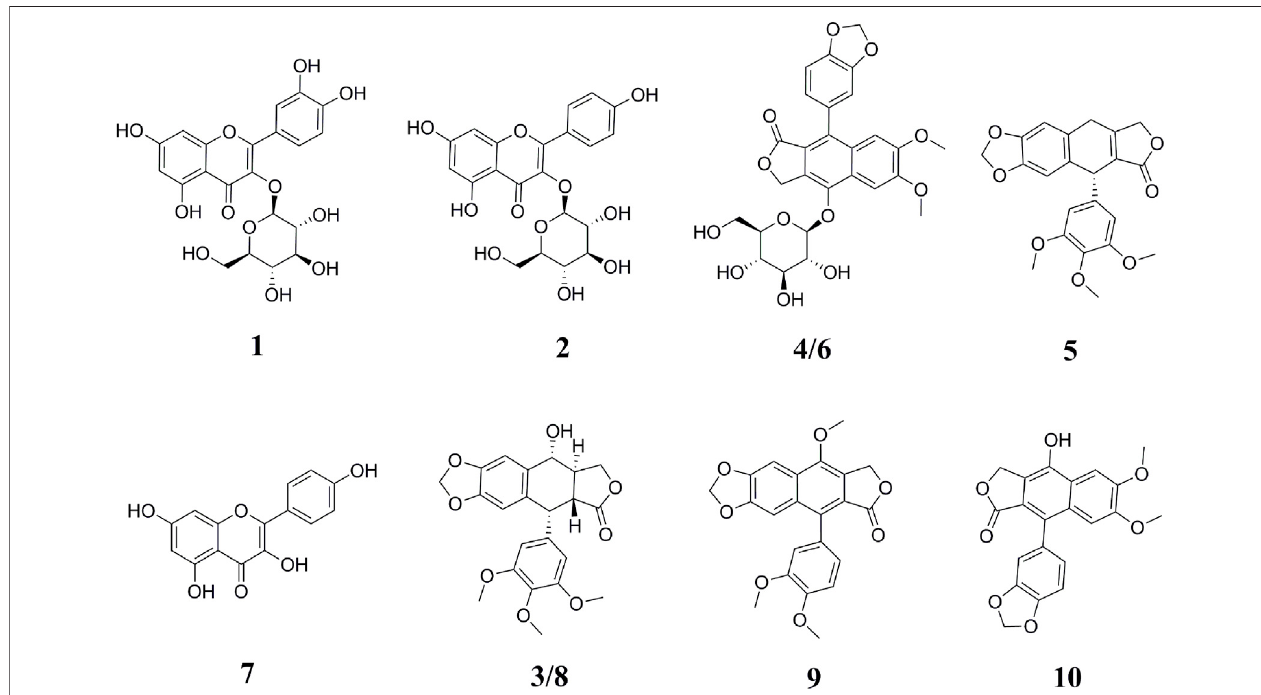
FIGURE 2 | Chemical structures of bioactive compounds identi fi ed from P. sinense based on the MS/MS spectra or the corresponding standards. The peak numbers in this fi gure correspond to those listed in Table 1 .